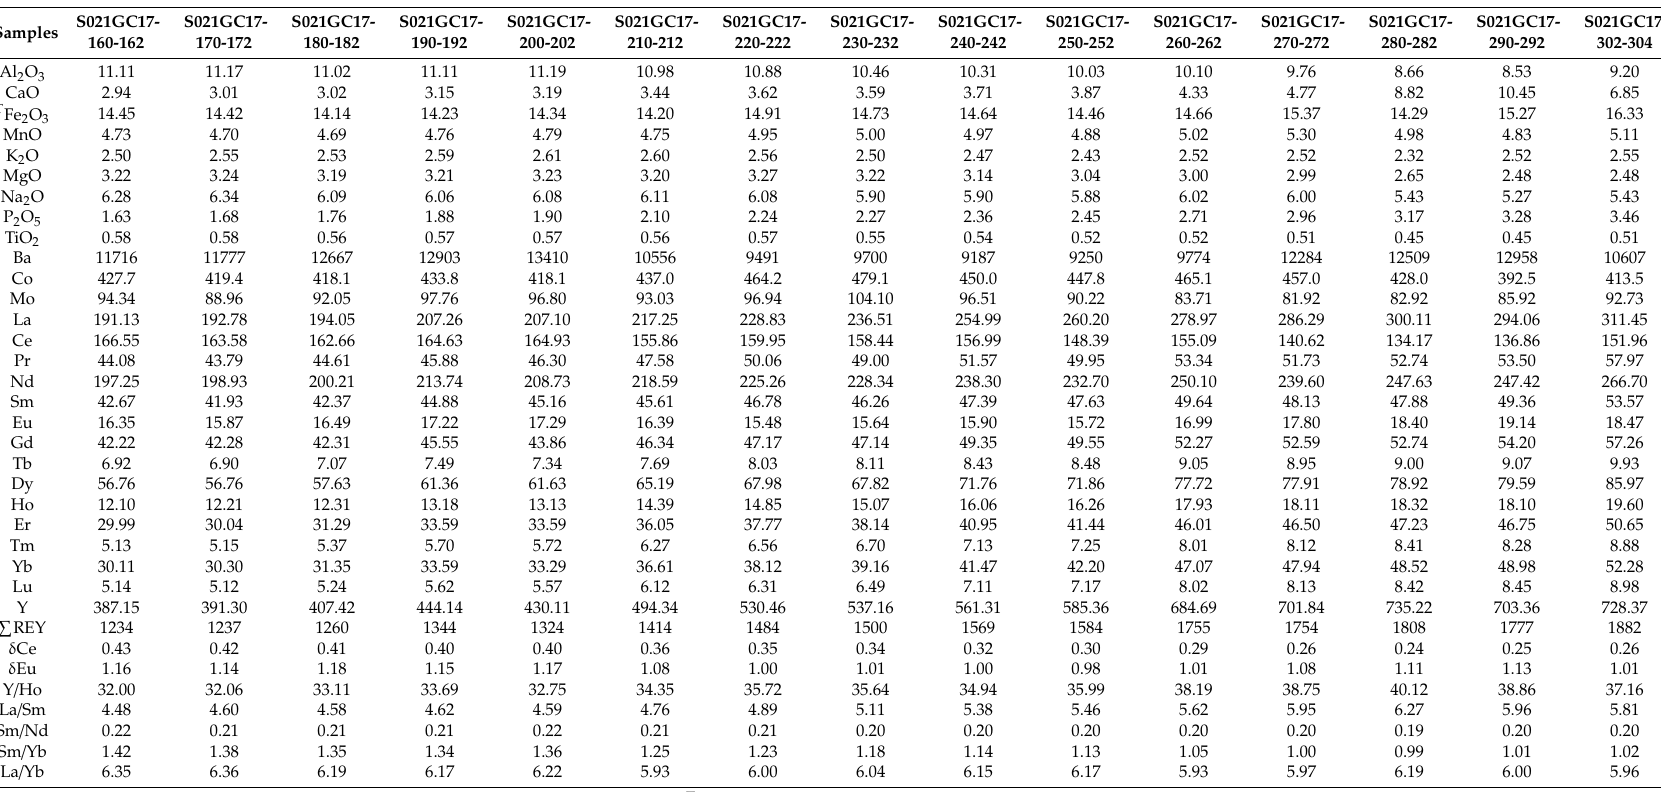
Table 1b. Bulk sediment geochemical data for the rare earth elements and yttrium (REY)-rich deep-sea sediments from the Yupanqui Basin. S021GC17- Samples